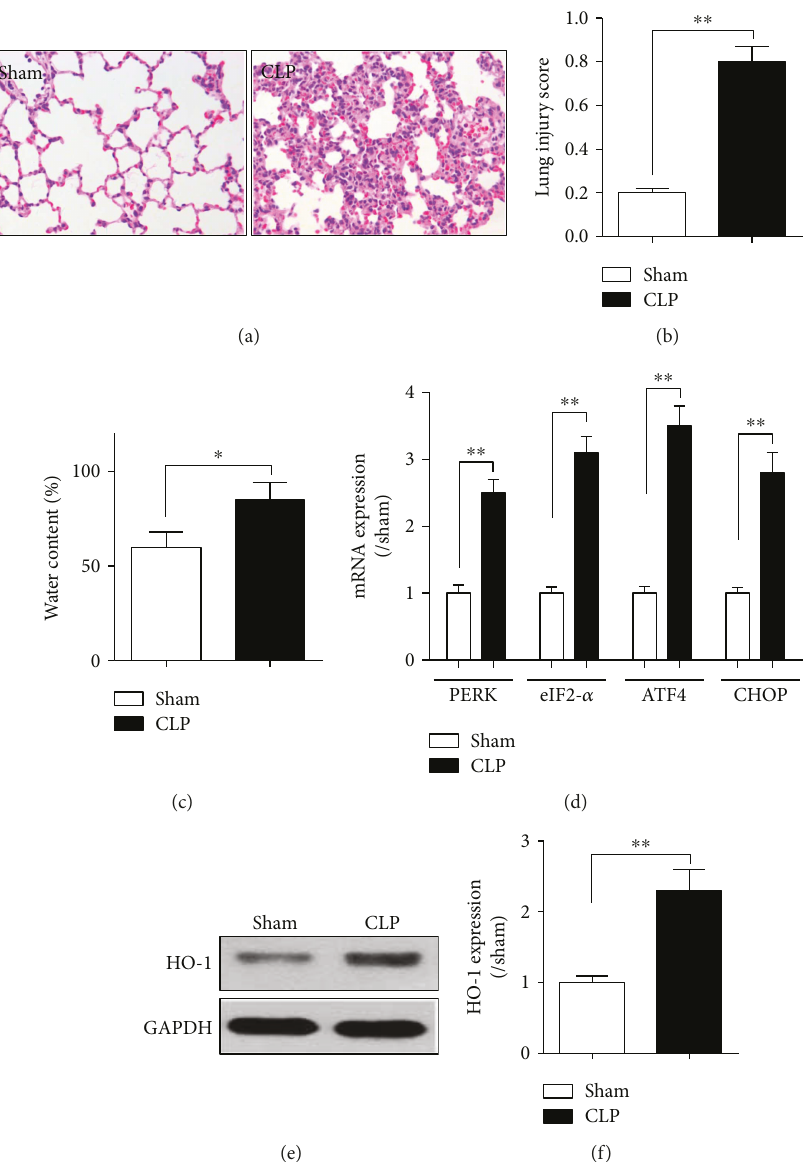
Figure 1: Pulmonary endoplasmic reticulum stress was activated during sepsis. Sprague-Dawley rats received cecal ligation and puncture (CLP) surgery or only laparotomy without CLP surgery (sham group). (a) Lung pathology was detected by using hematoxylin and eosin (H&E) staining. (b-c) Levels of the lung injury score and water content in lung tissues. After treatment with CLP for 18h, lung injury